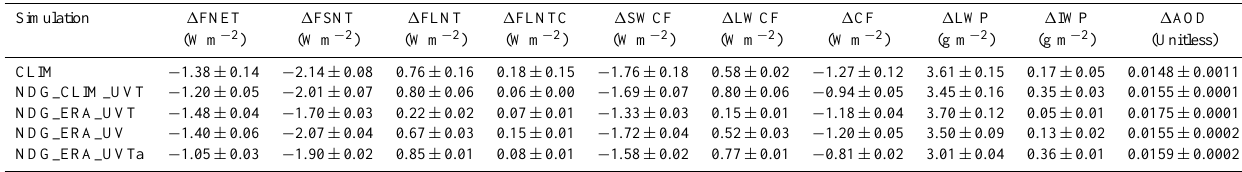
Table A2. As in Table A1 but for the aerosol induced changes (PD–PI differences, denoted by 1 ). FSNT, FLNT and FNET stand for the TOA net shortwave, long-wave and total radiation fluxes, respectively. Positive values denote downward fluxes. FLNTC is the clear-sky net long-wave flux. The other acronyms have the same meaning as in Table A1. Simulation 1 FNET